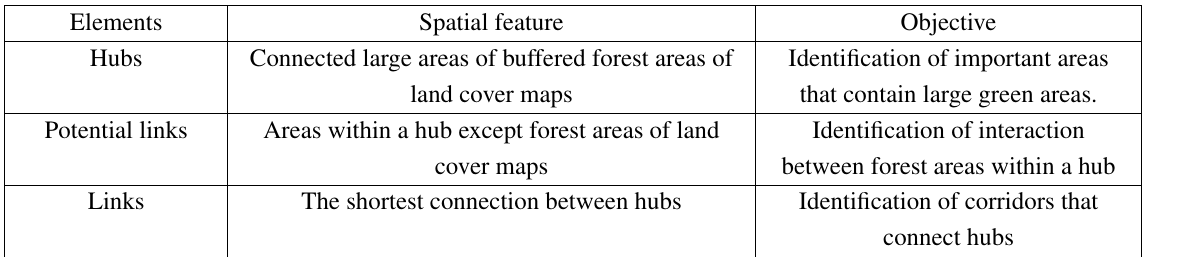
Table 2. Elements of green